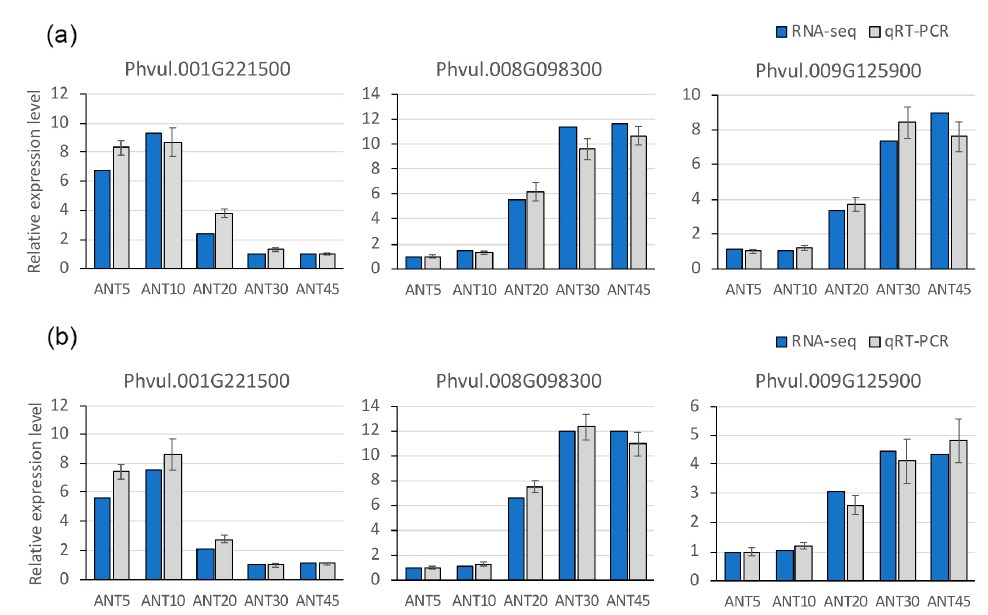
Figure 6. Validation of gene expression obtained from RNA-seq by qRT-PCR. The dynamic expression patterns of Phvul.001G221500, Phvul.008G098300, and Phvul.009G125900 transcriptions factors evaluated by qRT-PCR in PHA-1037 ( a ) and PMB0255 ( b ) accessions. Error bars represent the standard deviation of qRT-PCR from three biological and two technical replicates.